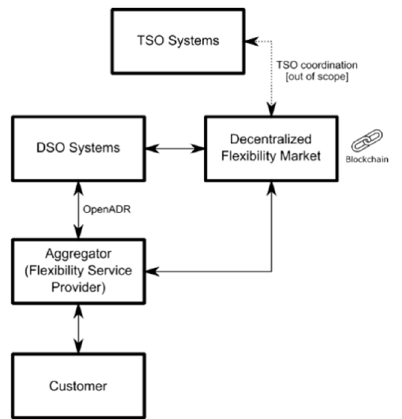
Figure 4. Hierarchy of the Proof of Concept (PoC). The PoC is the result of a successful collaboration between Enterprise and University.